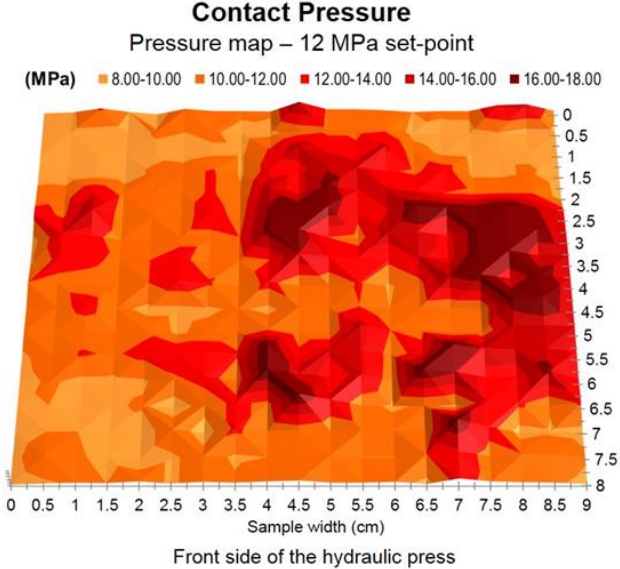
Figure 7. Distribution of the applied pressure over a 80 × 90 mm USIBOR 1500P ® steel sheet blank (ArcelorMittal, Luxembourg City,